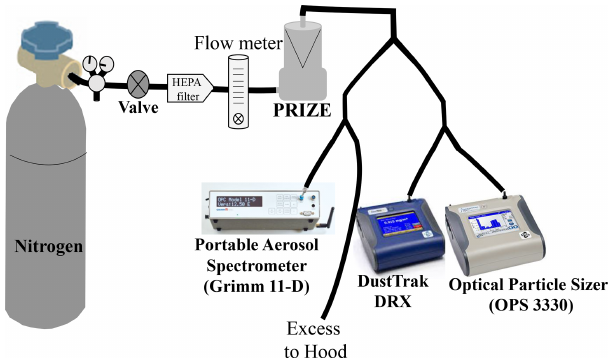
Figure 2. Experimental setup: Arizona Test Dust (ATD) particles were generated using the PRinted FluidIZed bed gEnerator-3D dust generator (PRIZE) and measured by the various instruments (Dust- Trak, OPS, and Grimm